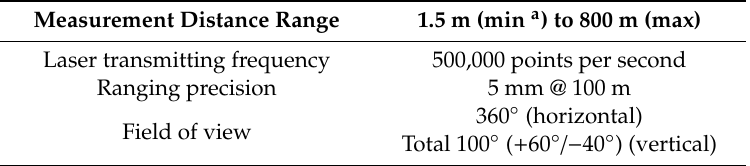
Table 1. Riegl VZ-400i terrestrial scanning system technical